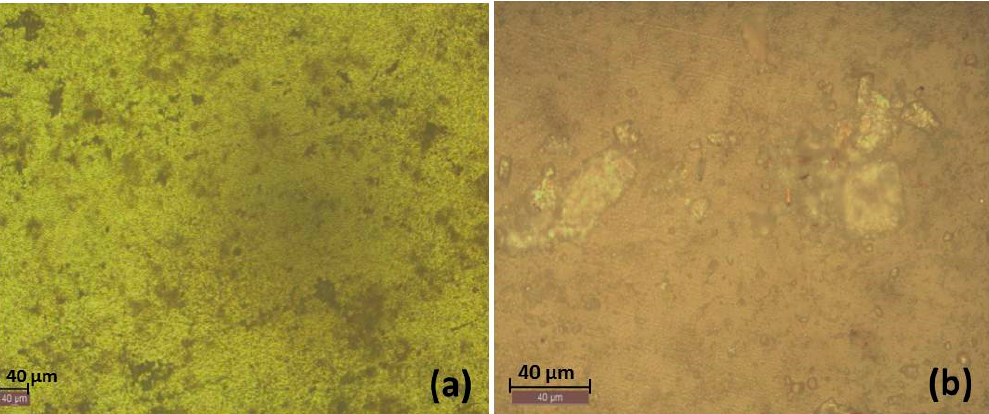
Figure 17. Optical images of PEO coating surface after 10 days of immersion in 3.5% NaCl solution ( a ) low magnification, ( b ) enlarged magnification.